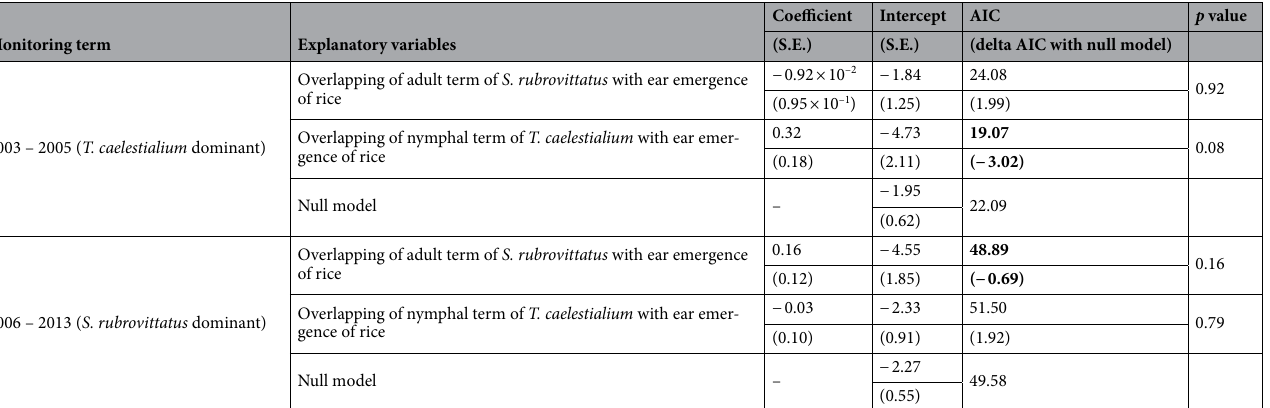
Table 4. Generalized linear mixed effect model (GLMM) for the occurrence of crop damage over the two divided study periods (2003–2005 and 2006–2013). Objective variables were occurrence of crop damage, explanatory variable were overlapping days. Bold indicated the lower AIC value compare with that of null model. p value indicates the result for t-statistics using Satterthwaite’s method for denominator degrees of